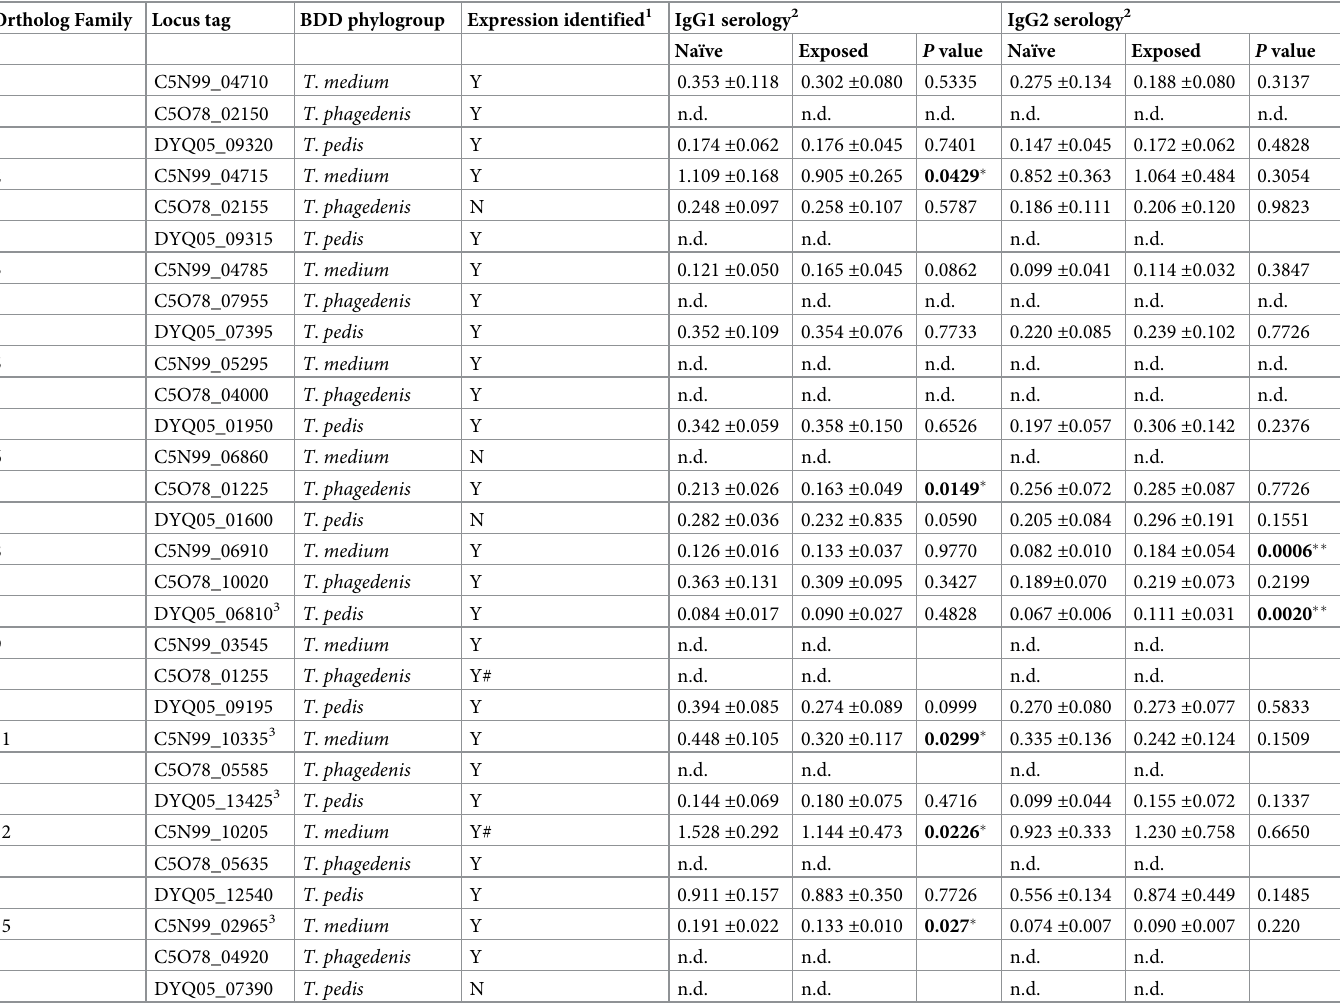
Table 5. Serological assessment of IgG1 and IgG2 responses to putative treponemal OMP ortholog family members by ELISA. Ortholog Family Locus tag BDD phylogroup Expression identified 1 IgG1 serology